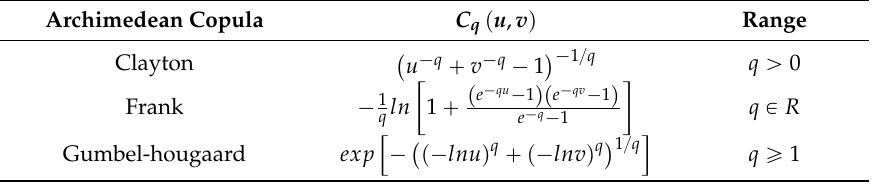
Table 1. Three common Archimedean copula functions in the field of hydrology research.